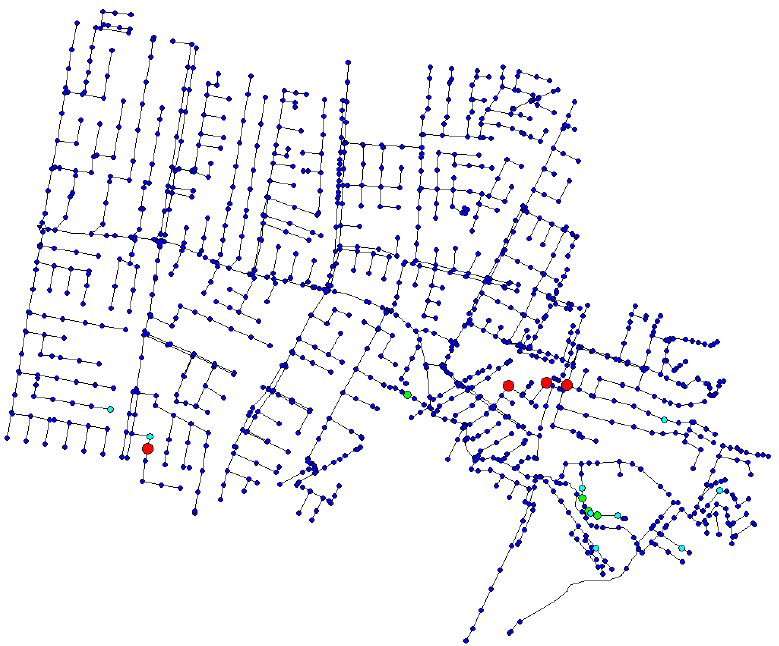
Figure 10. Results for the initial assessment of the Northern Chicó Network.